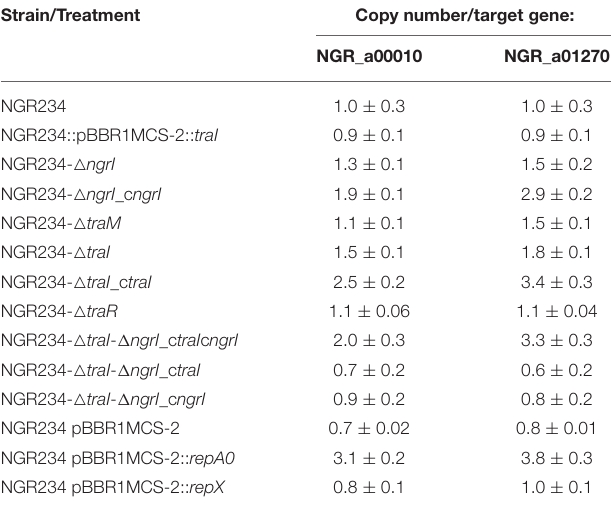
TABLE 2 | Copy number of pNGR234 a estimated using qPCR and primers for the ORFs NGR234_a00010 and NGR234_a01270.